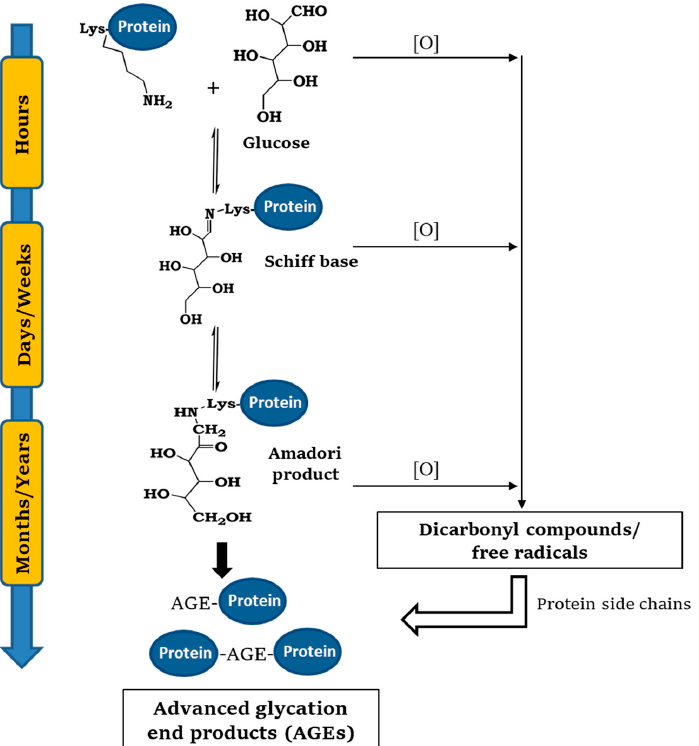
Figure 1. General mechanism of protein glycation. The process is initiated by a spontaneous nucleophilic addition reaction between the free amino group of a protein, generally belonging to N-terminal and lysine side chain, and the carbonyl group of a reducing sugar. This reaction rapidly forms a reversible Schiff base, which rearranges over a period of weeks to produce ketoamine or Amadori product. The Amadori product undergoes an irreversible cascade of reactions involving dehydration, hydrolysis, and rearrangements leading to the formation of advanced glycation end products